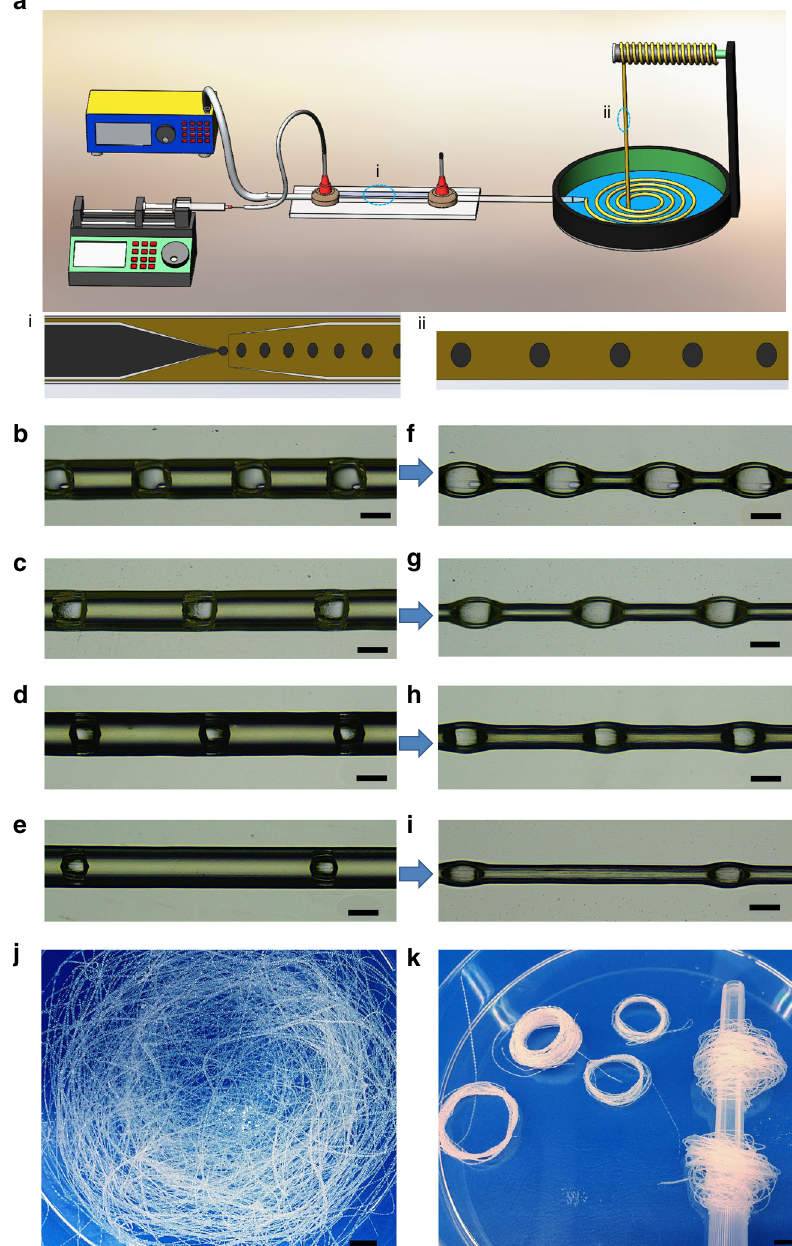
Fig. 1 Schematic diagram showing the experimental set-up for the fabrication of cavity-micro fi bers. a Schematic diagram of the gas-in-water capillary- based micro fl uidic system. b – e Optical images of hydrated cavity-micro fi bers under different fl ow rates of continuous phase Q jet and gas pressure of dispersed phase P gas ( b ) 0.6 mL h − 1 : 22.40 kPa; ( c ) 0.6 mL h − 1 : 20.96 kPa; ( d ) 1 mL h − 1 : 26.04kPa; ( e ) 1 mL h − 1 : 24.07 kPa. f – i Optical images of dehydrated cavity-micro fi ber corresponding to ( b – e ). j – k The collected dehydrated cavity-micro fi bers in large quantities. Scale bars, 100 μ m in ( b – i ) and 6 mm in ( j – k